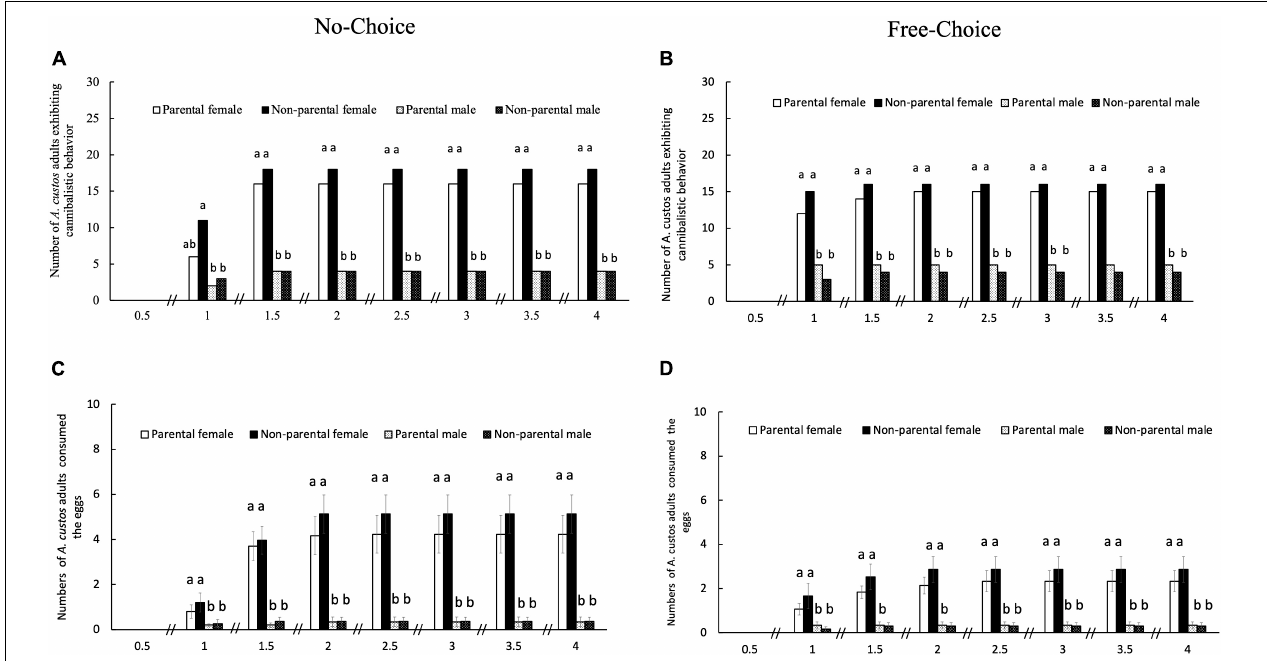
FIGURE 6 | Real-time egg cannibalistic behavior observed in male and female A. custos adults for 4 days at different times. Cannibalistic behavior did not change after 4 days of incubation with eggs. Under the no-choice condition, each A. custos adult was incubated with 30 parental or 30 non-parental eggs, whereas under the free-choice condition, each adult was simultaneously incubated with 15 parental and 15 non-parental eggs. A total of 30 replicates were used for each food choice. Different lowercase letters on pillars indicate significant differences ( p < 0.05). A total of 30 replicates were used for each food-choice experiment. Numbers of A. custos adults exhibiting cannibalistic behavior in no-choice (A) and free-choice (B) condition. Numbers of A. custos adults consumed the eggs in no-choice (C) and free-choice (D)